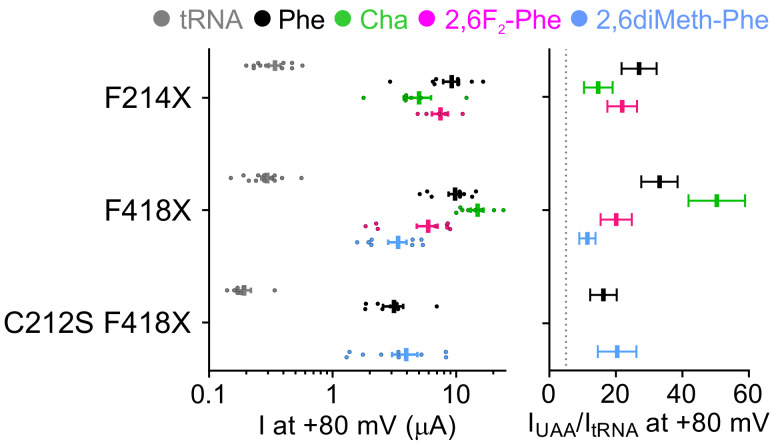
Site-specific incorporation of non-canonical amino acids into CLC-0 channels is efficient and yields robust currents.(left panel) Mean current I at +80 mV in Xenopus laevis oocytes for F214X, F418X and C212S F418X CLC-0 co-injected with empty tRNA (gray) or tRNA misacylated with Phe (black), Cha (green), 2,6F2-Phe (pink) and 2,6diMeth-Phe (cyan). Individual data points are shown as circles and the mean ± S.E.M. is shown as a vertical bar with error bars. (right panel) For all constructs, IUAA/ItRNA was calculated from the means of IUAA and ItRNA at +80 mV as reported in the left panel. Errors were propagated. A threshold of IUAA/ItRNA >5 is imposed for specific incorporation efficiency (dashed line). The raw data is available in Figure 7—figure supplement 3—source data 1.Figure 7—figure supplement 3—source data 1.Individual data points.